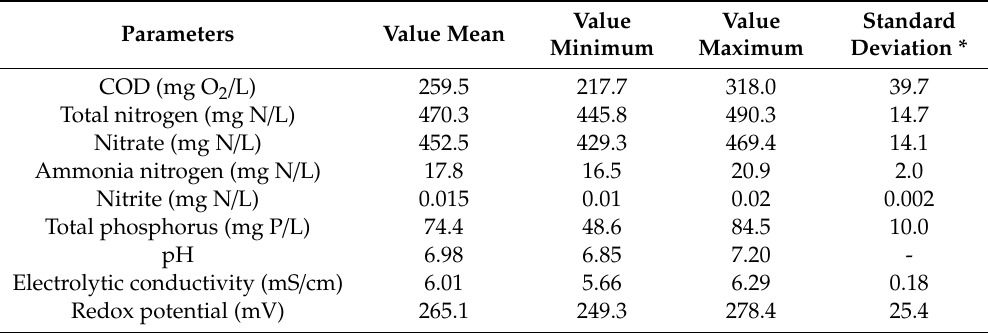
Table 1. Synthetic raw wastewater composition and